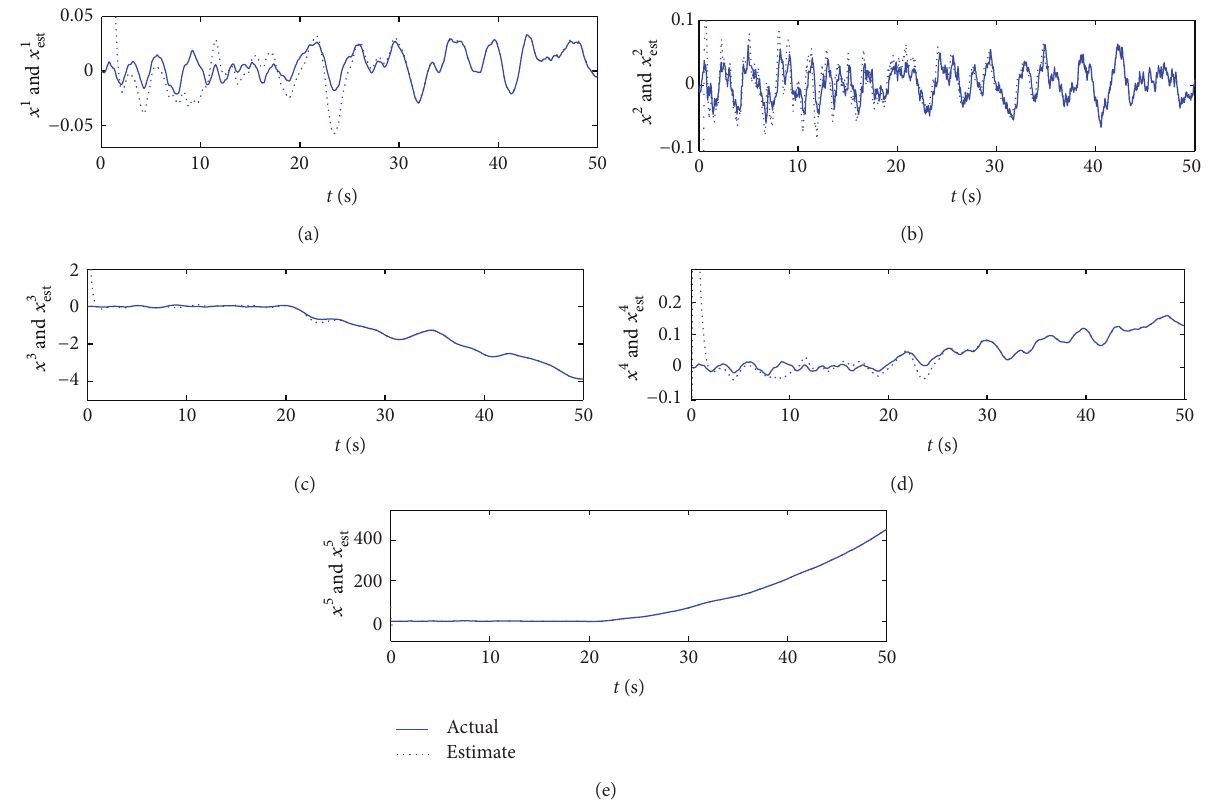
Figure 7: Actual state variables and estimations when a stuck fault in elevator occurred at 20